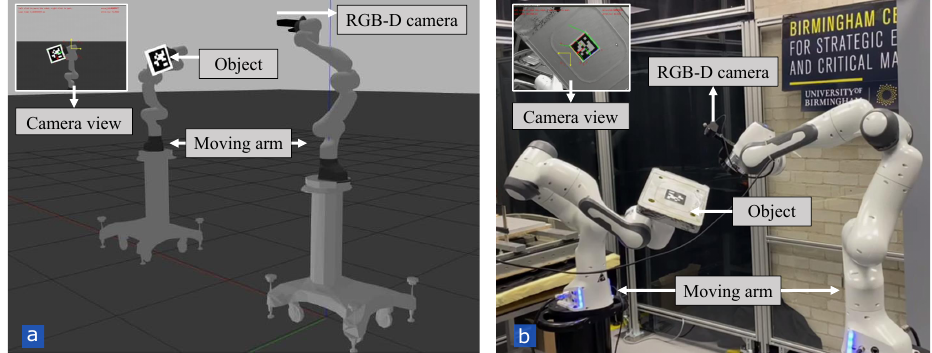
Figure 4. The modelled setup 1 in ( a ) the simulation hlenvironment, and ( b ) the real